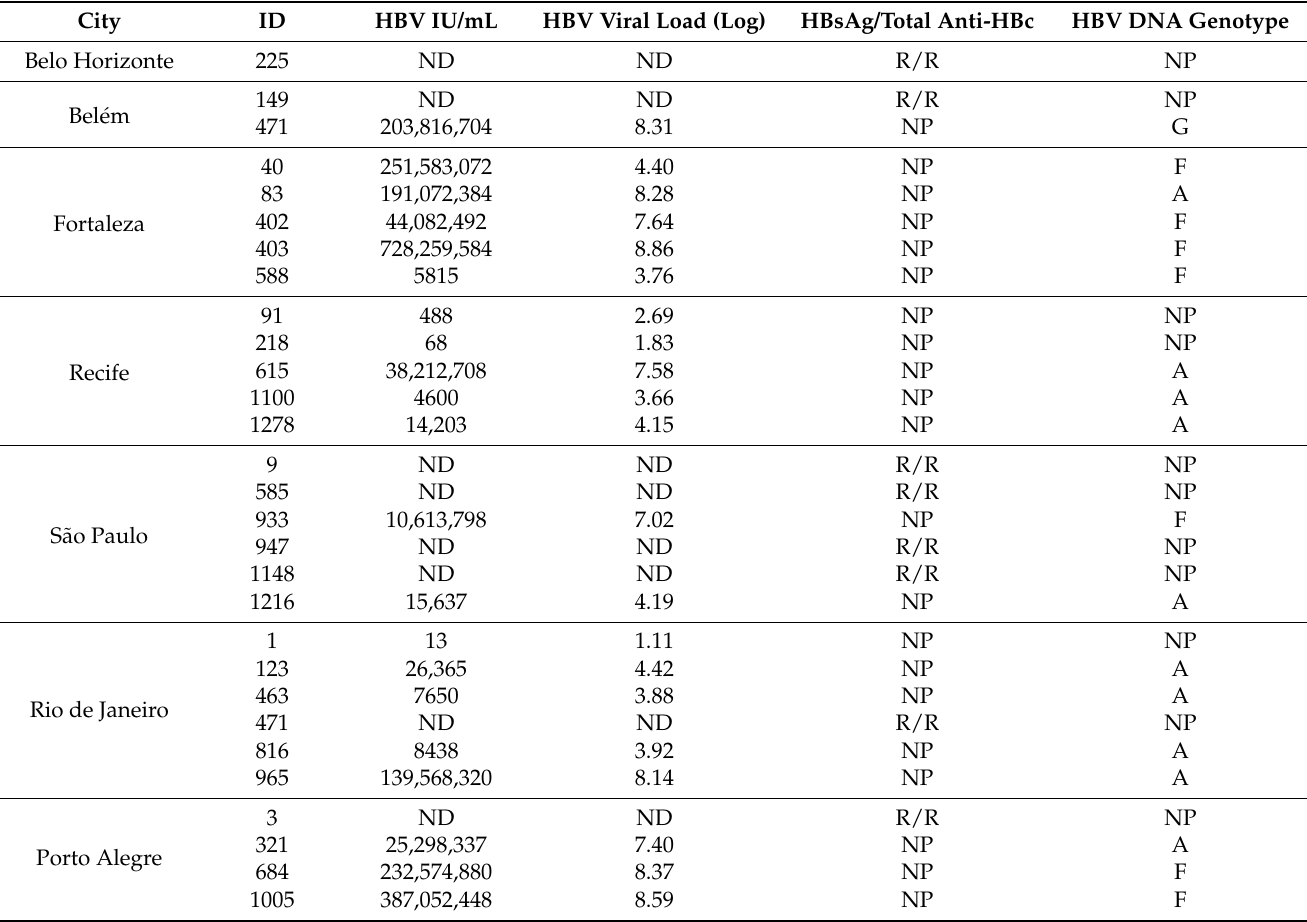
Table 1. Results from serological (RT, CLIA) and molecular (Viral Load) hepatitis B virus markers and HBV DNA genotypes identified from the samples analyzed from MSM studied, Brazil. HBsAg/Total Anti-HBc HBV DNA